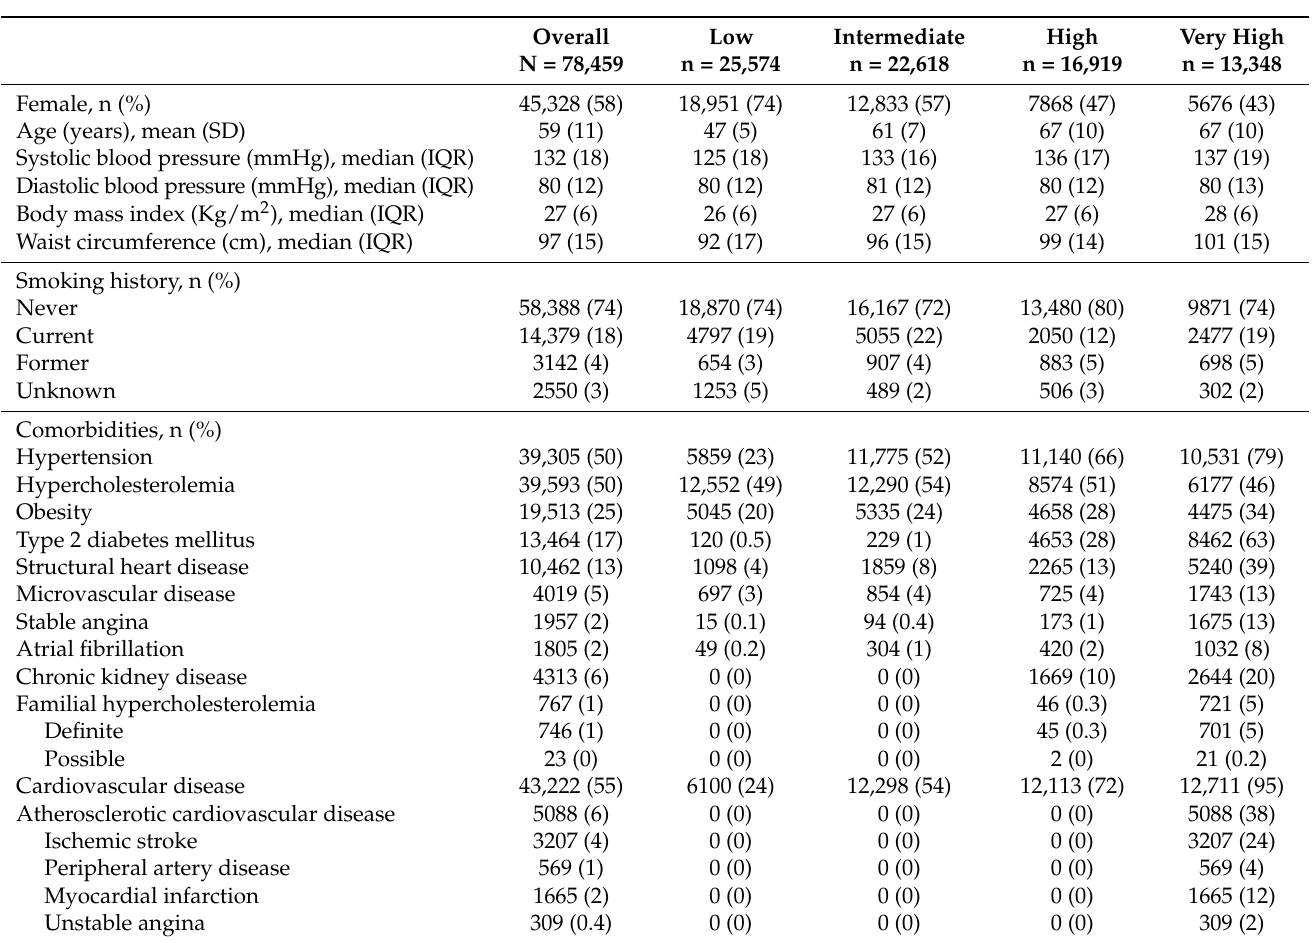
Table 1. Sociodemographic and clinical characteristics by cardiovascular risk category on 31 Decem- ber